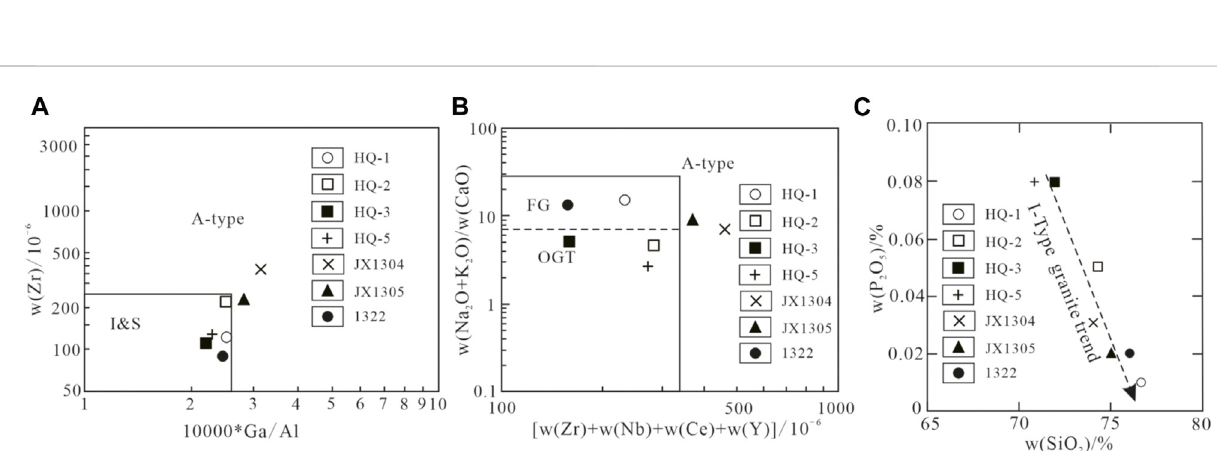
FIGURE 11 Discrimination diagrams for I-type granites in the Xinchenggou area, Dongning County. 10,000*Ga/Al versus Zr plots of A-type granites and I-, S-type granites (rectangular boxes) (A) (after Whalen et al., 1987); Zr+Nb+Ce+Y versus (Na 2 O+K 2 O)/CaO plots of A-type granites and also fi elds for FG and OGT (B)